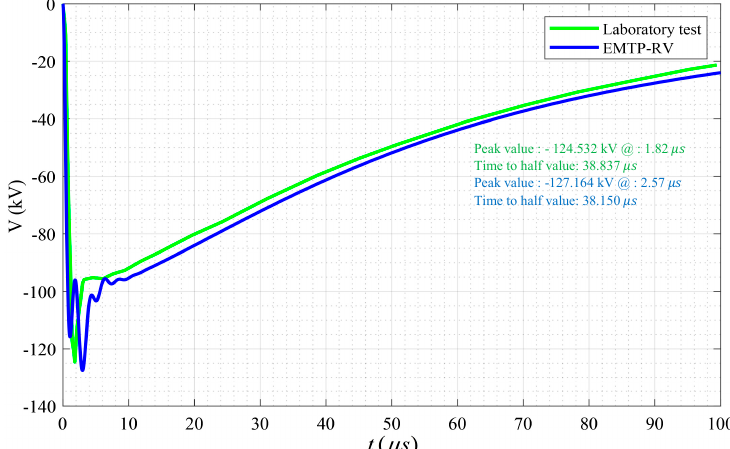
Figure 14. Applied impulse 110 kV in the presence of 119 μH filtered spark gap, laboratory test and EMTP-RV model.